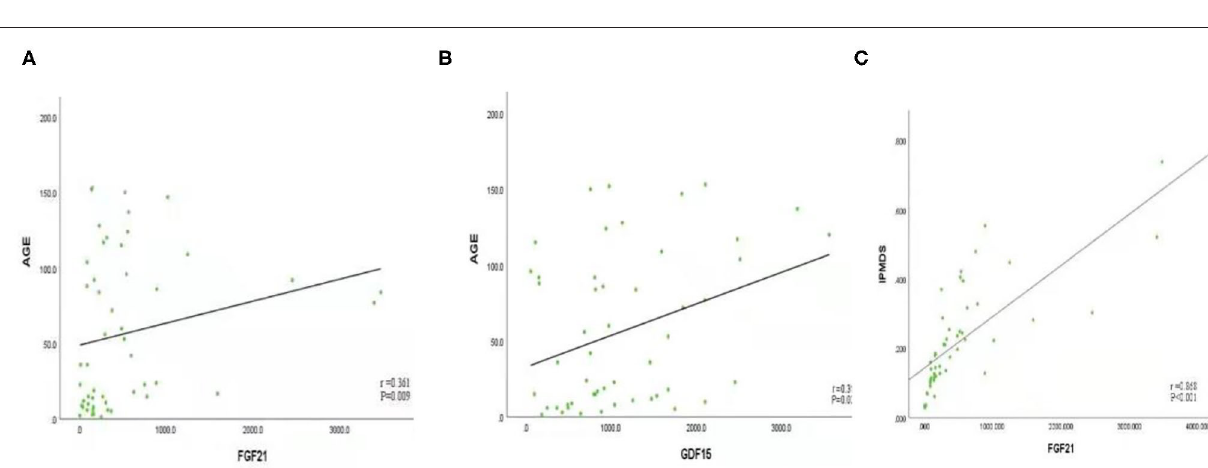
FIGURE 2 | Receiver operating characteristic (ROC) curve of each biomarker in diagnosis of PMDs.